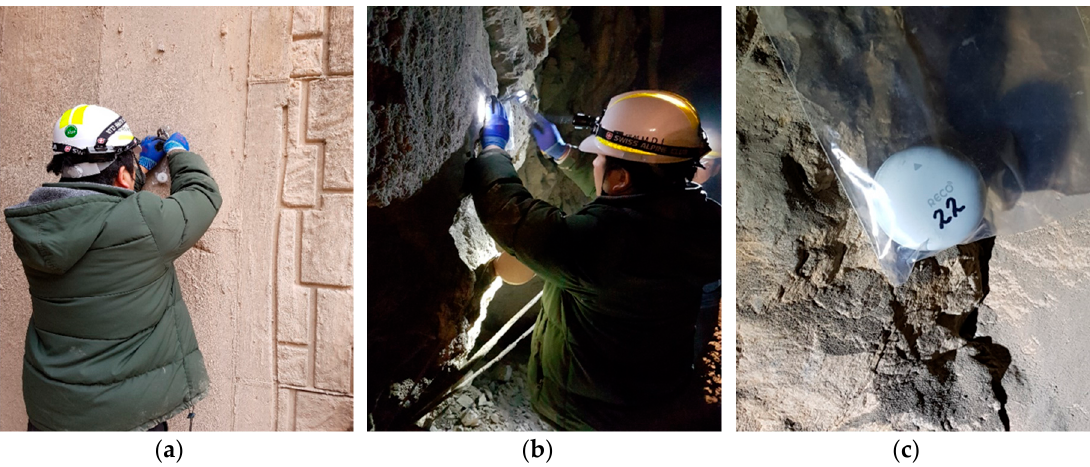
Figure 4. Installing Bluetooth beacons ( a ) in the portal of the mine and ( b ) in the underground mine; ( c ) Bluetooth beacon with minor ID 22.